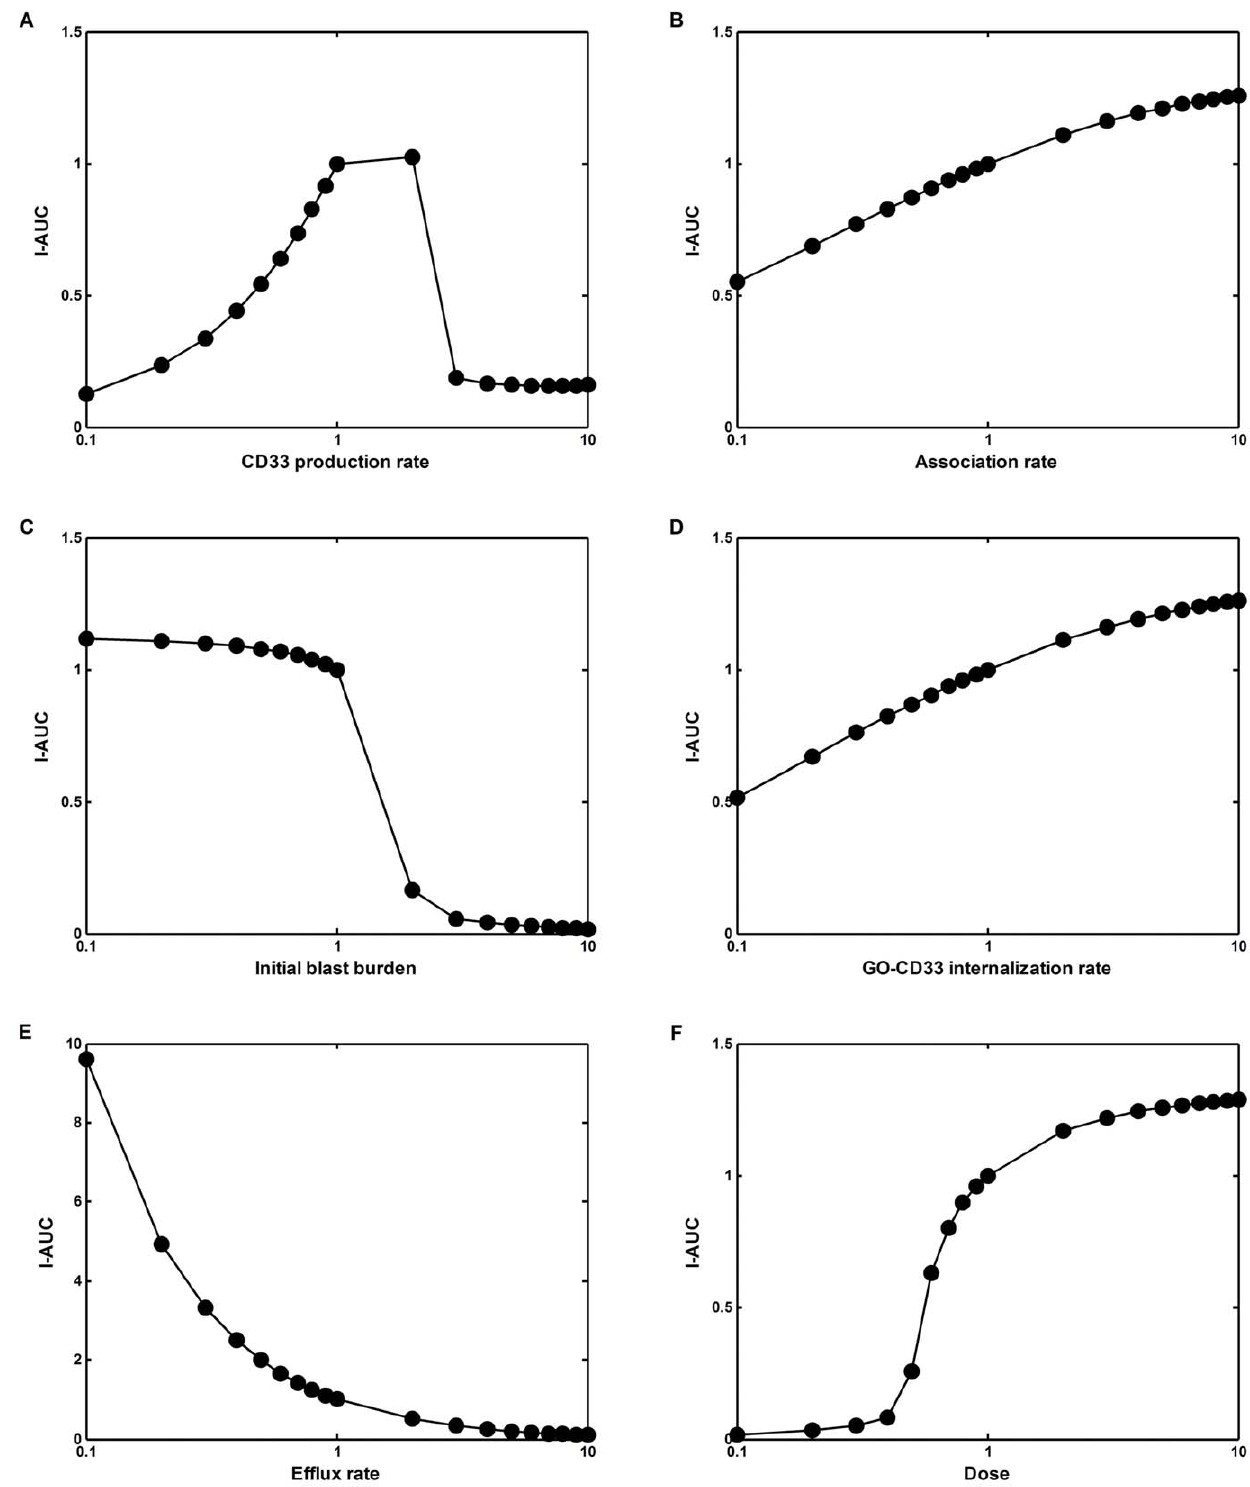
Figure 4. Parameter sensitivity analysis. Intracellular AUC of GO was calculated for different parameter sets. Each time only one parameter was varied, including CD33 production rate ( A ), association rate ( B ), initial blast burden ( C ), internalization rate ( D ), efflux rate ( E ), and total drug dose ( F ). All the other parameters were kept constant at their mean values (Table 1). I-AUC values were normalized to the value obtained for the set of mean parameter values. Parameter values are expressed in relative units after normalization to their mean values.